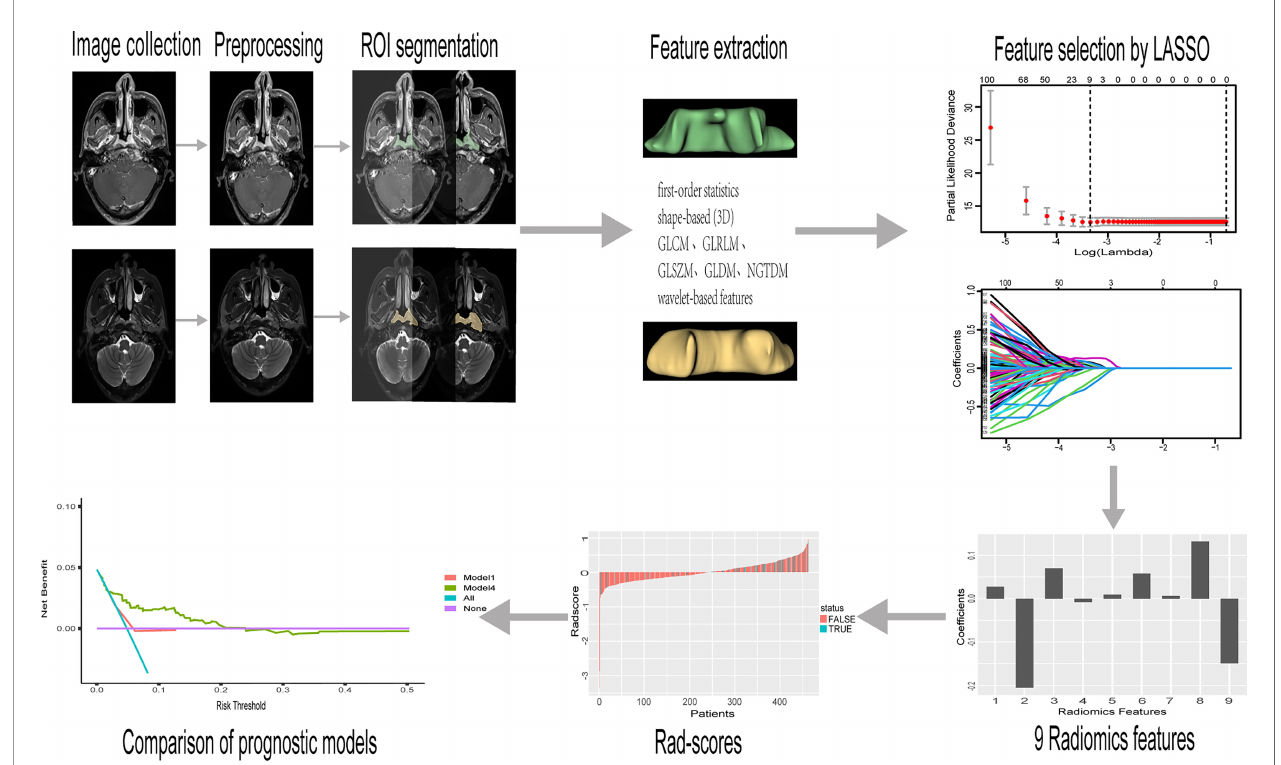
FIGURE 1 | The work fl ow of MRI-based radiomic analysis. After manual tumor segementation, 2074 features of each patients were extracted. Radiomics features selection by the LASSO algorithm. These selected features were linearly fi tted according to the weights of the coef fi cients to calculate the rad-score. Decision curve analysis (DCA) compared the net bene fi t rate between the TNM stage system (Model 1 ) with our nomogram model (Model